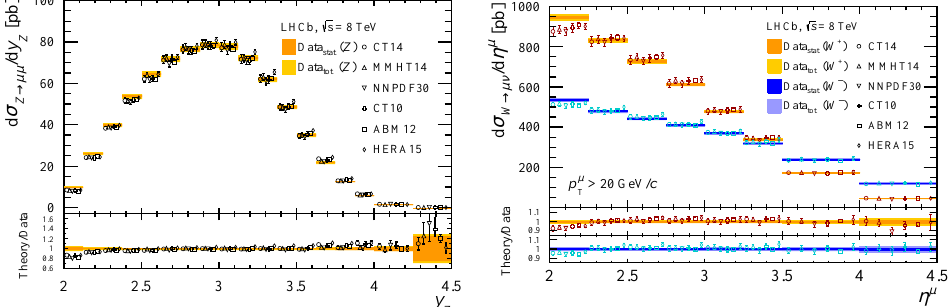
Figure 1: Measured Z (left) and W (right) boson differential cross sections at (cid:112) s = 8TeV [ 3 ]